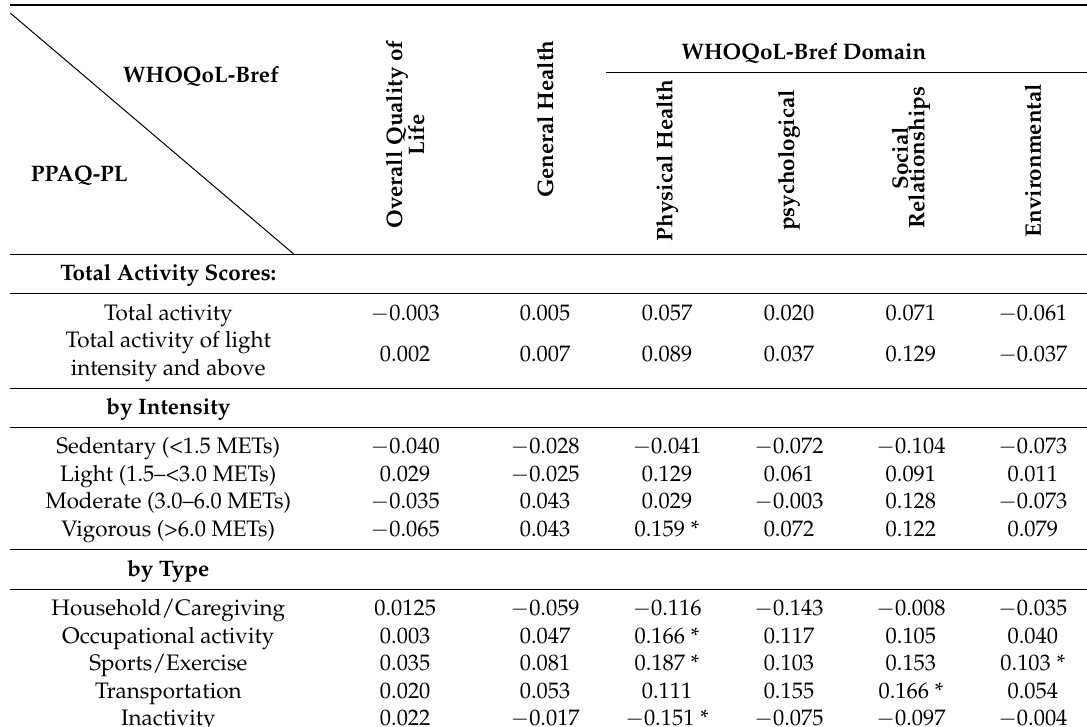
Table 3. Spearman’s correlation coefficients between the Pregnancy Physical Activity questionnaire (PPAQ-PL) and Quality of Life-Bref Questionnaire (WHOQoL-Bref) in women in the second trimester of